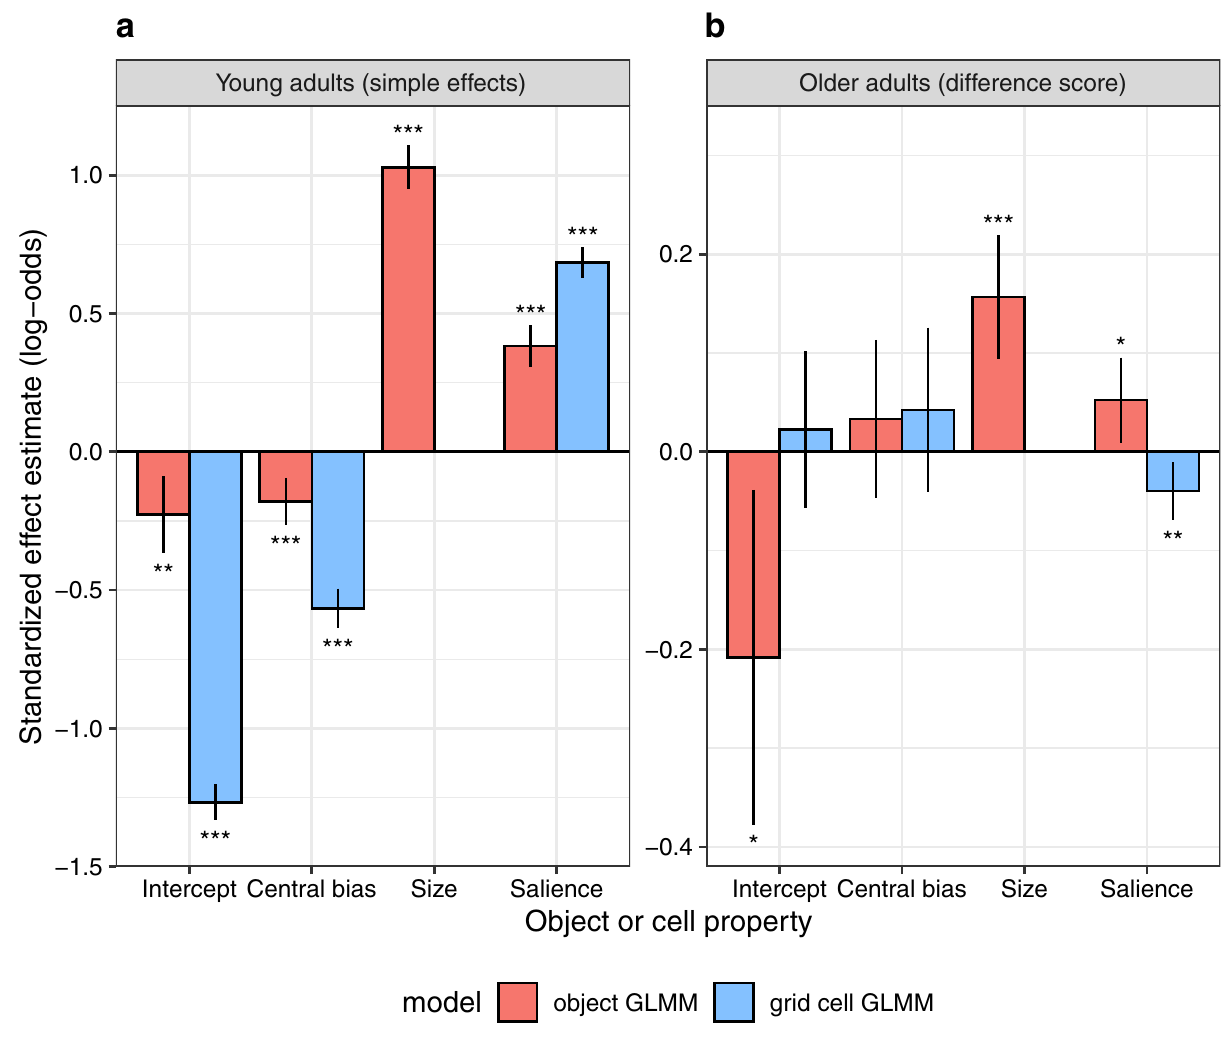
Figure 4. Fixed-effects results from the object GLMM (red bars) and the grid GLMM (blue bars), each fitting fixation probability during scene viewing for young (left) and older (right) adults. In particular, effects of object- based (red) and location-based (blue) visual salience on fixation probability are compared. ( a ) Effects that were estimated for the young adults. ( b ) Difference scores, describing the difference between older and young adults. Error bars indicate 95% confidence intervals. Stars denote coefficients that were significantly different from zero (* p < .05, ** p < .01, *** p < .001). Different to the object GLMM, the grid GLMM did not include a fixed-effect for size because all cells in the grid were of equal